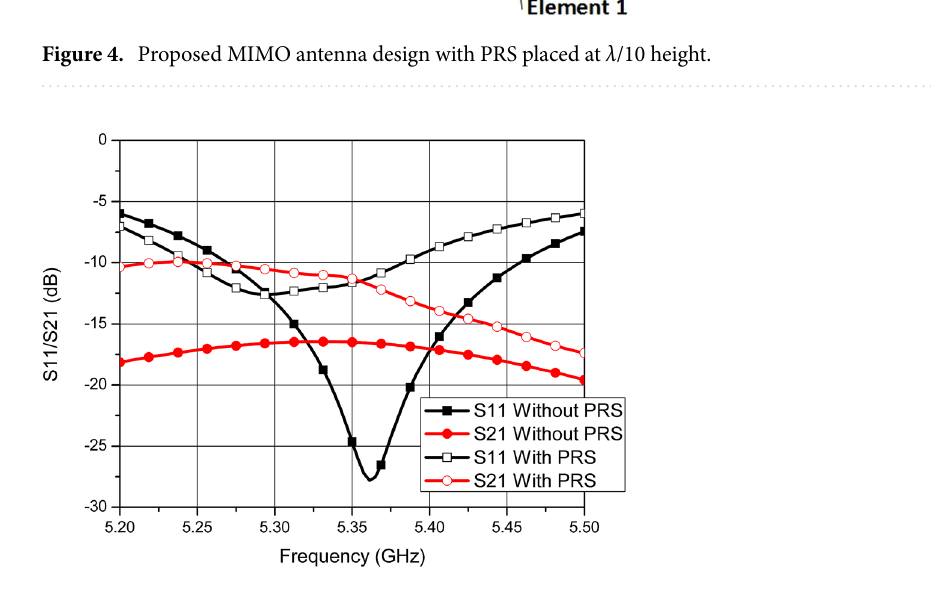
Figure 5. Simulated S-parameters of MIMO antenna with and without the